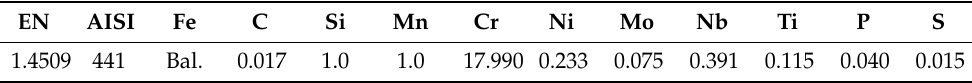
Table 1. Chemical composition of steel sample. All data in mass percentage.